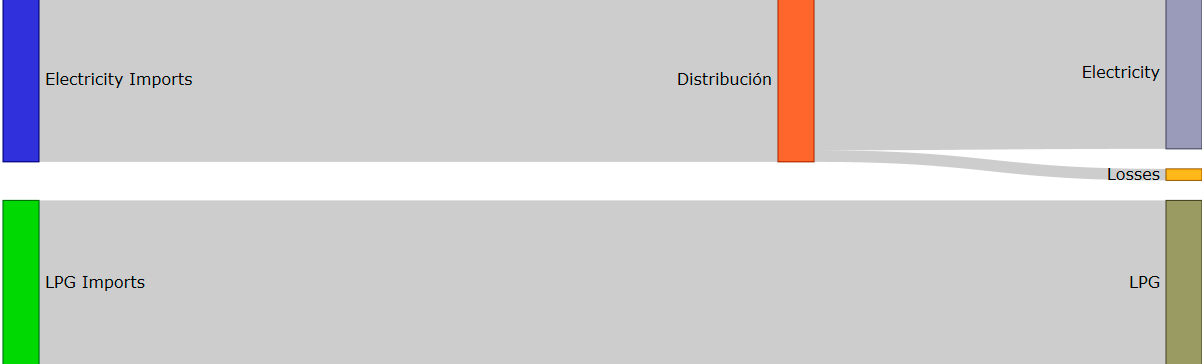
Figure 10. Scenario 3. Energy consumption in 2030, residential sector.